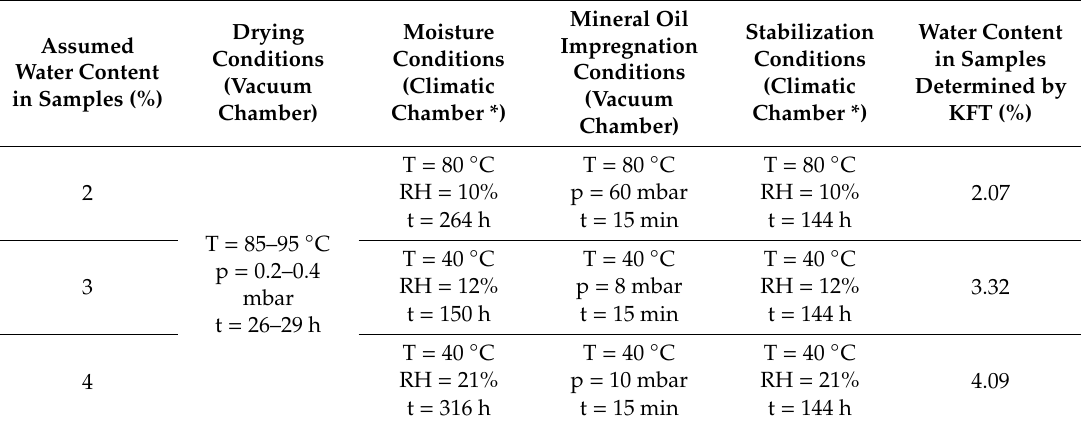
Table 1. Samples preparation parameters.